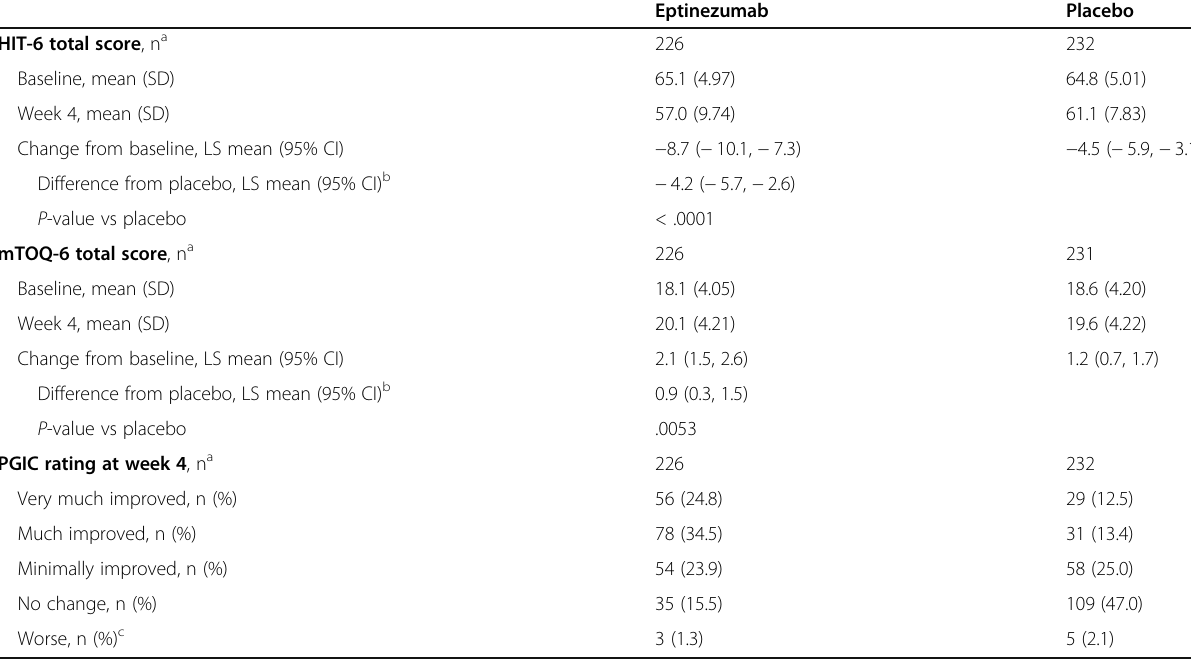
Table 2 Patient-reported outcomes at baseline and week 4